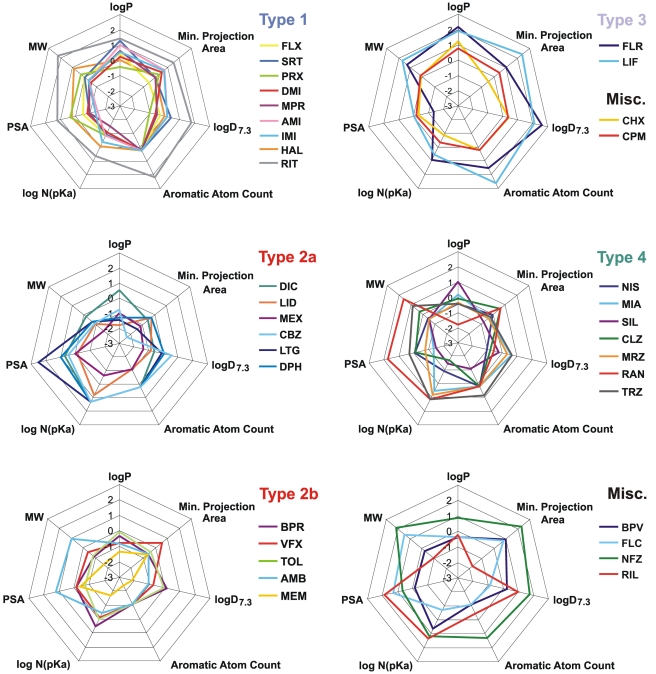
Selected chemical descriptors of drugs illustrated on radar diagrams.Different panels show different types of inhibition. ‘Type 2’ drugs were divided into two panels as in Figure 3, for the sake of visibility. For individual values of properties see Results S6.